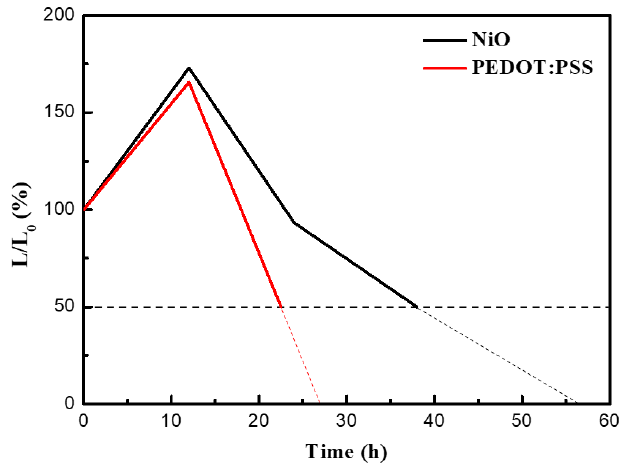
Figure 7. The operational lifetime characteristics of QLEDs with NiO or PEDOT:PSS as the HIL. The luminance of QLEDs was measured at a constant current density (0.07 mA/cm 2 ) corresponding to an initial luminance of 500 cd/m 2 .